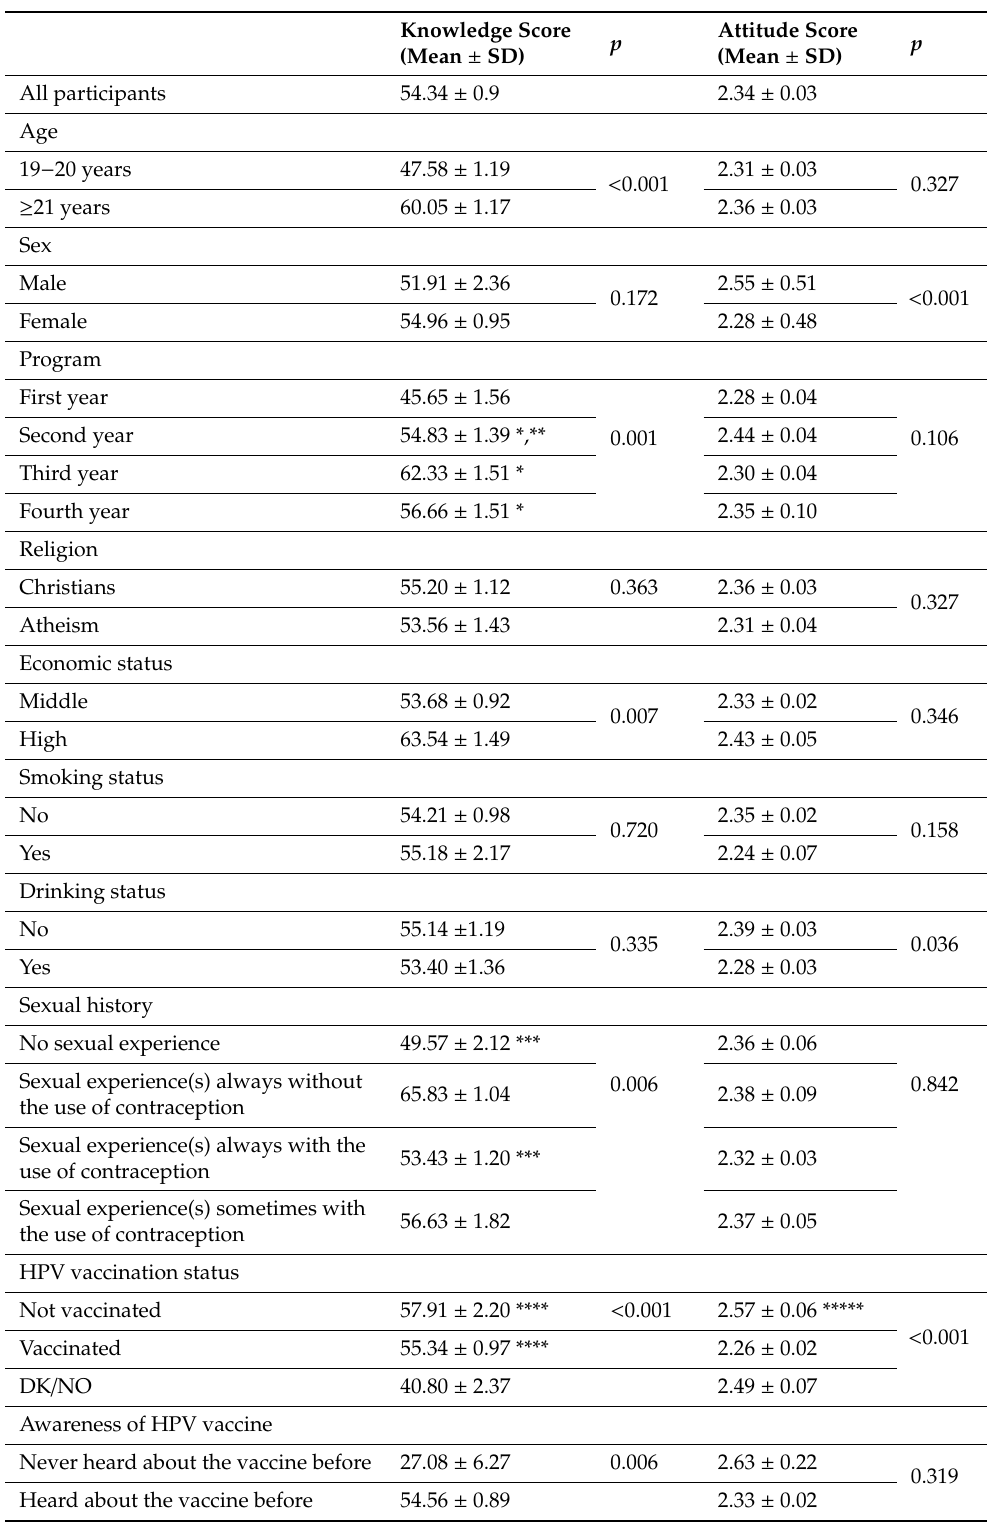
Table 3. Students’ knowledge and attitude scores stratified by their